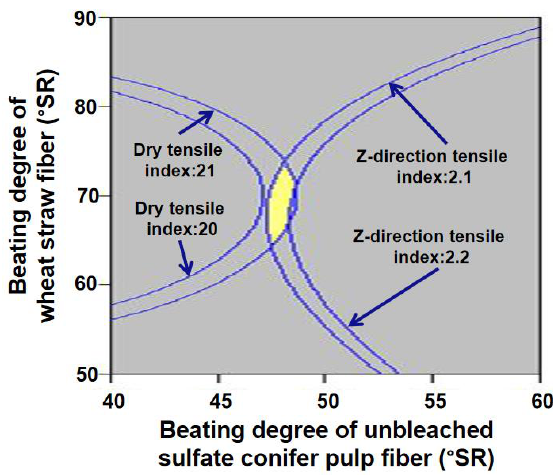
Figure 3. Optimum analysis of modulation adjustment parameters.